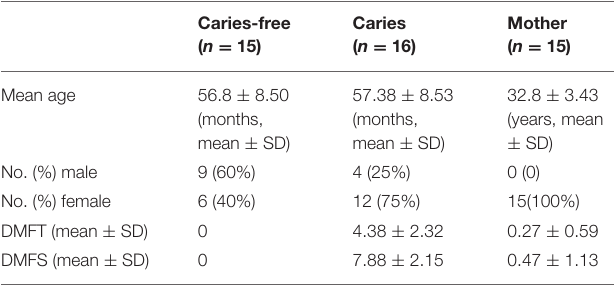
TABLE 1 | Demographic and clinical characteristics of study